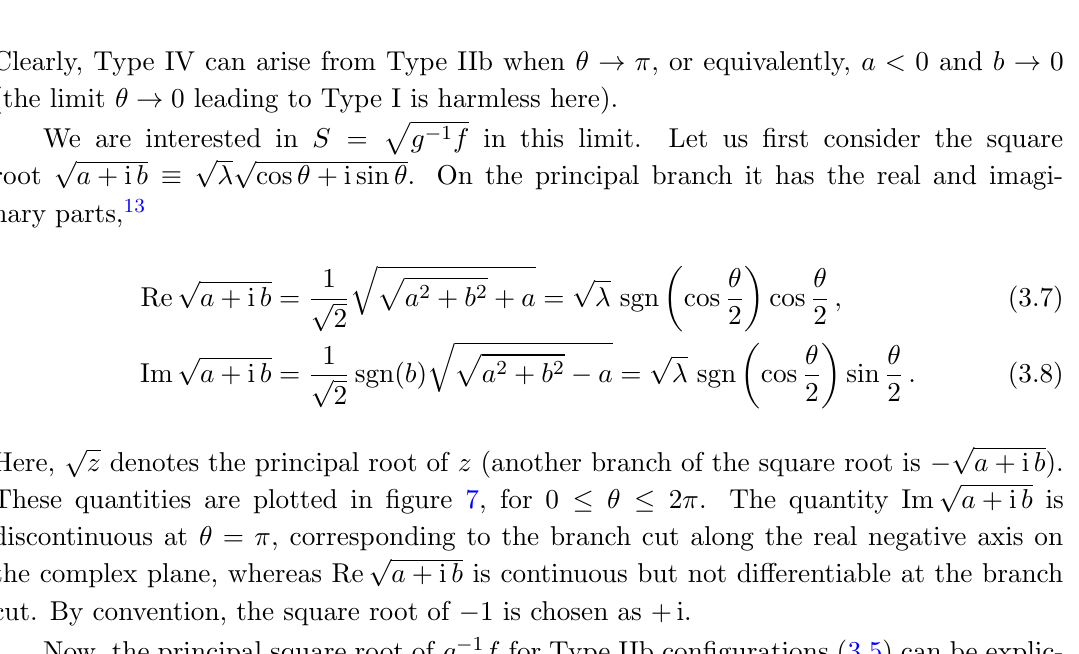
Figure 7 . Type IV ( (cid:18) = (cid:25) ) as a branch cut of Type